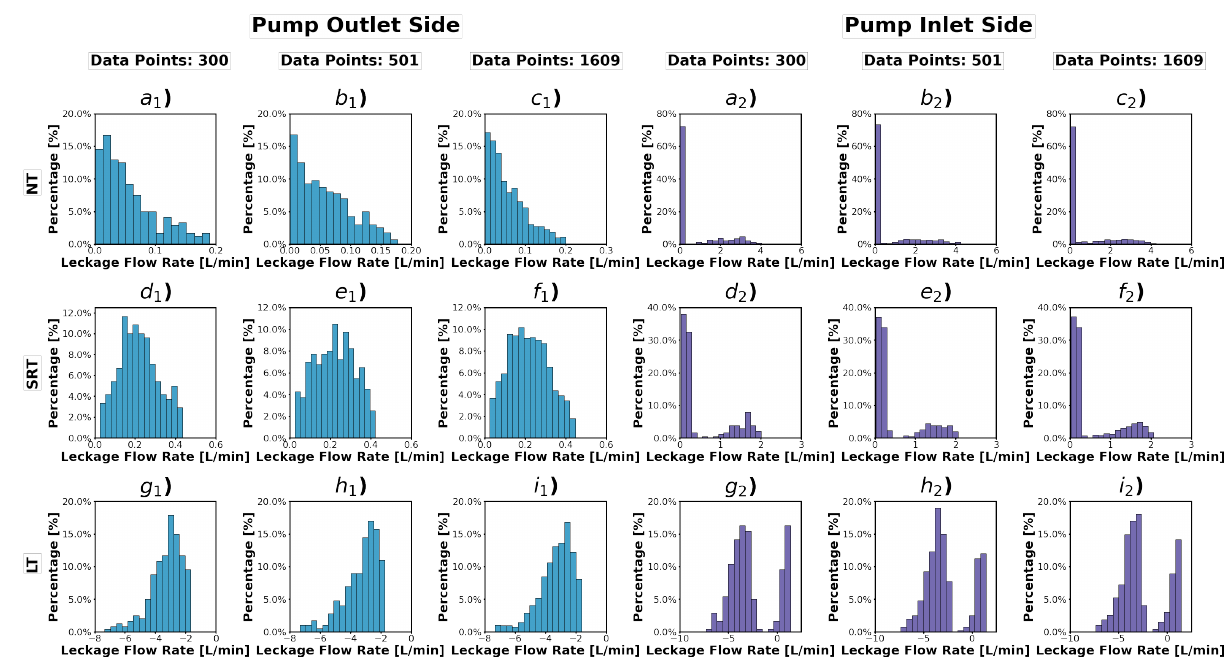
Figure 3. Relative histogram of label data with different data sizes and label transformation method. ( a 1 ) Model: 300 data points about leakage at pump outlet side without transformation. ( b 1 )